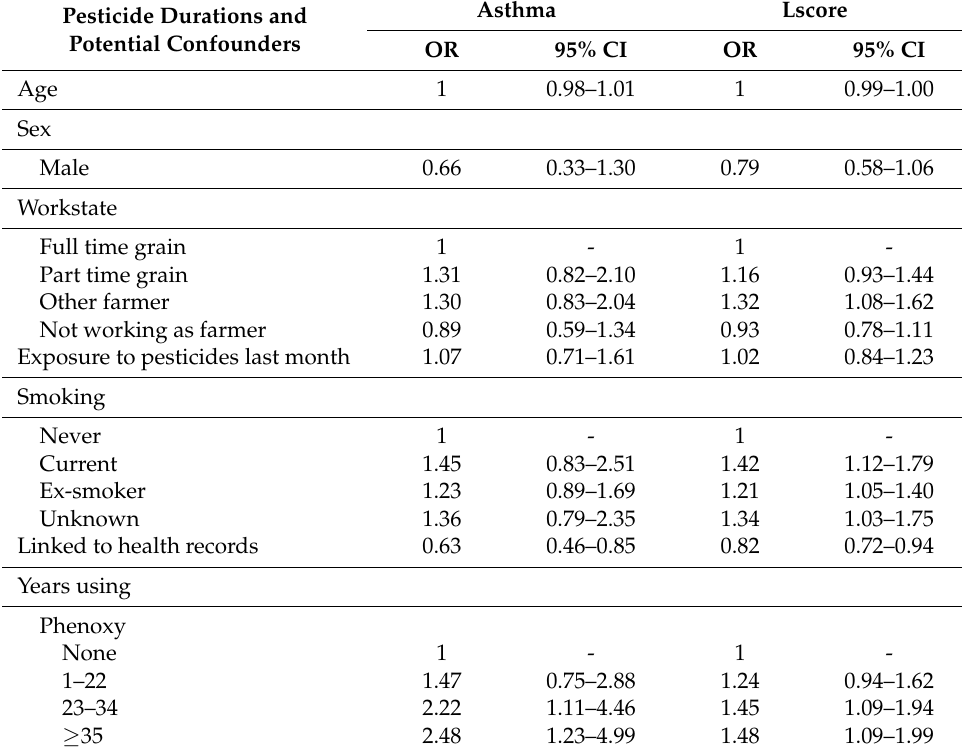
Table 5. Multivariable regression of exposures and potential confounders on self-reported asthma and Lscore (likelihood of asthma recorded in health records) ( N = 2420